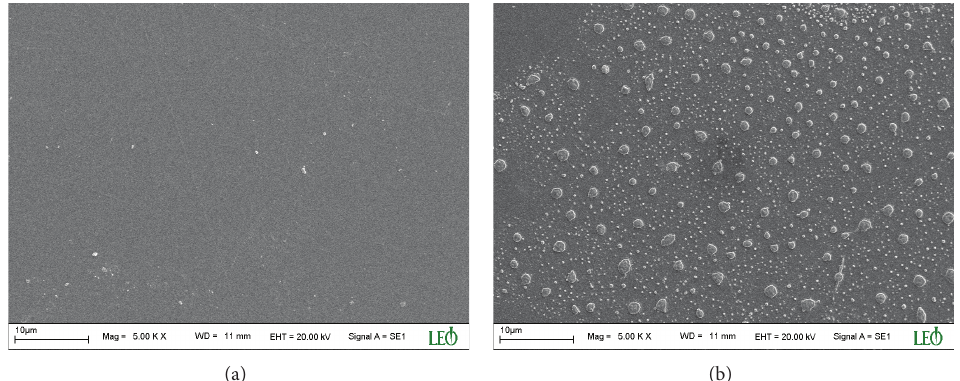
Figure 7: The SEM images of (a) short-time and (b) long-time DBD treated samples.